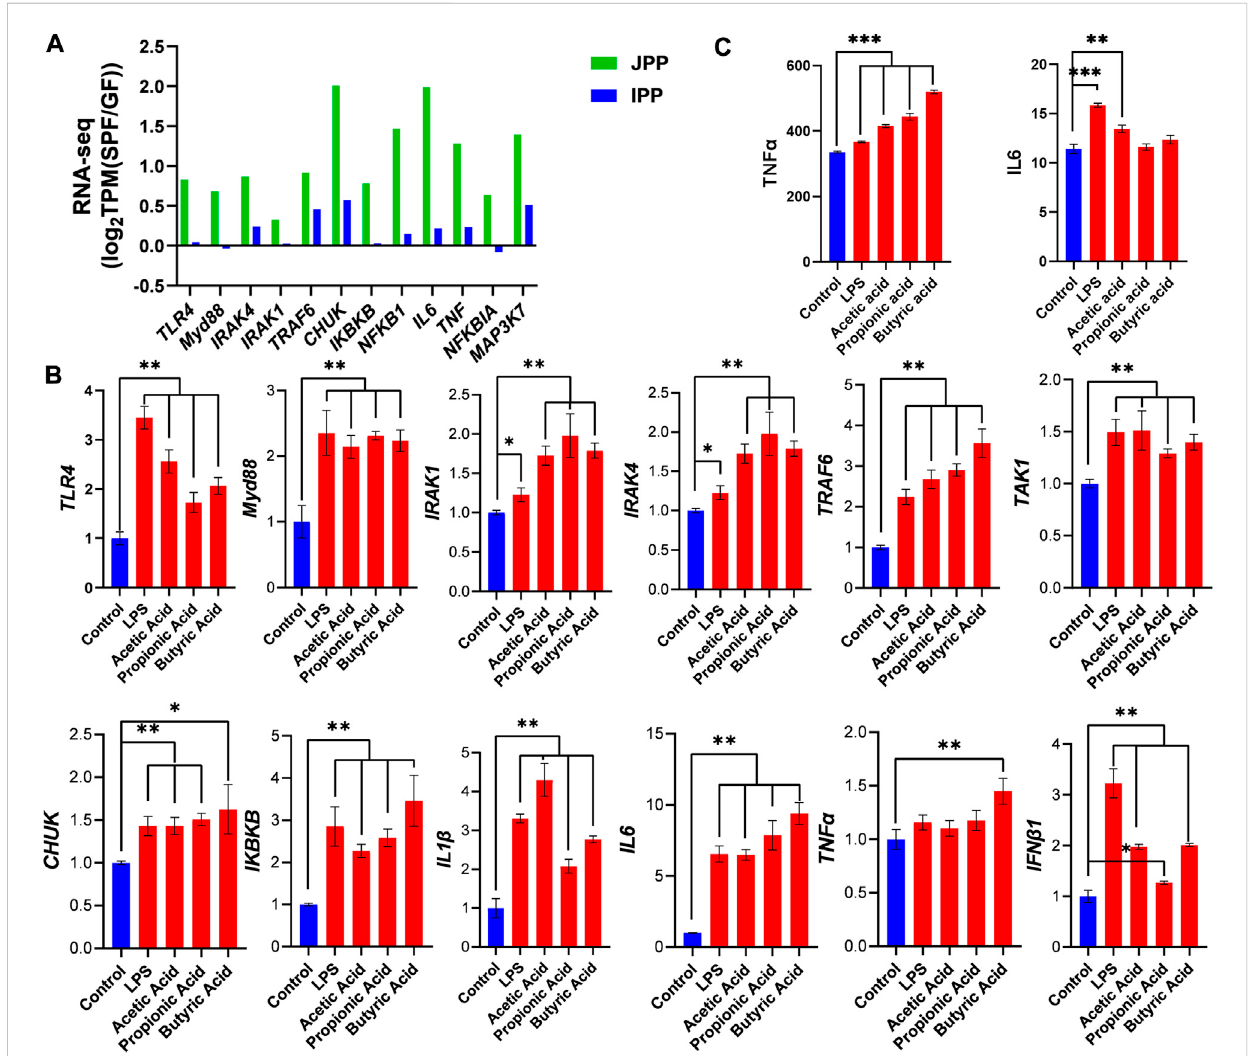
FIGURE 6 Commensal microbiota induces the TLR4 signaling pathway. (A) The expression of TLR4 signaling pathway-related genes in JPPs and IPPs [log 2 TPM(SPF/GF)]. The expression of TLR4 signaling pathway-related genes (B) and the secretion of IL6 and TNF α (C) were detected after 48 h stimulation with LPS or SCFAs (acetic acid,propionic acid and butyric acid) inHmy2. cir cells. Means ± SDs are presented for each group. n = 3. * p < 0.05, ** p < 0.01 and *** p <